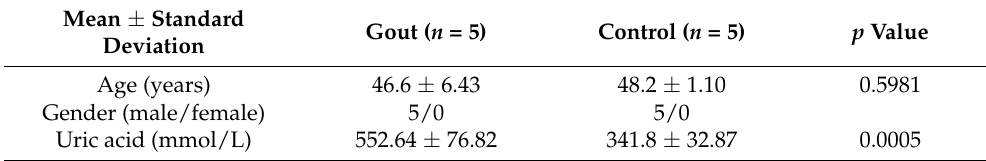
Table 4. Comparison of data of patients in two